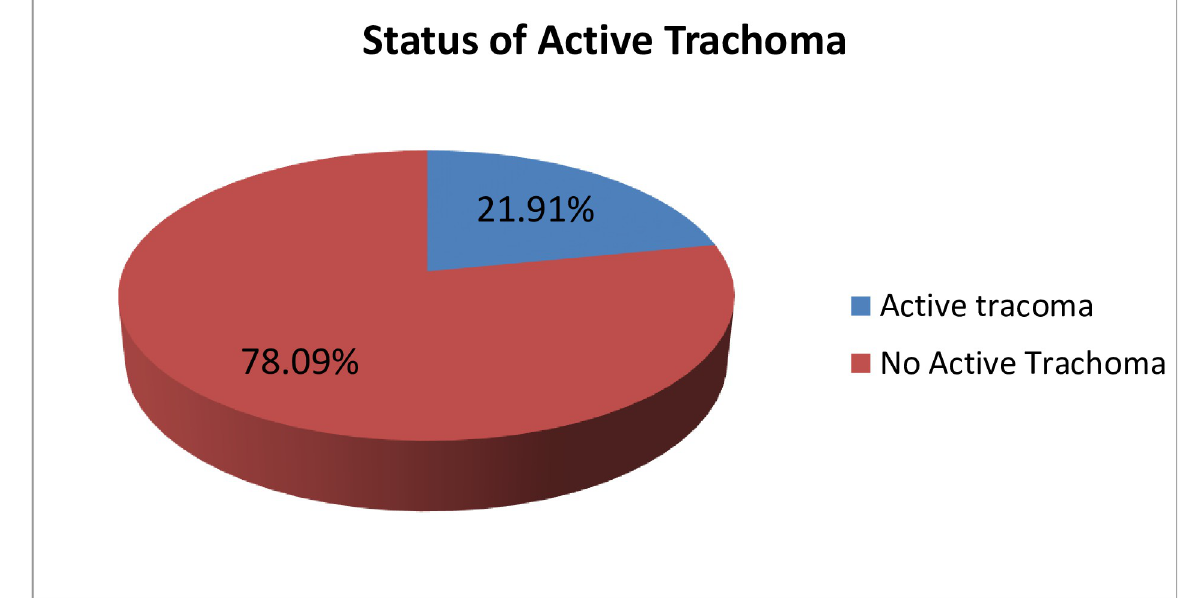
Fig 1. Status of active trachoma among children aged 1–9 years in Arsi Negele town.